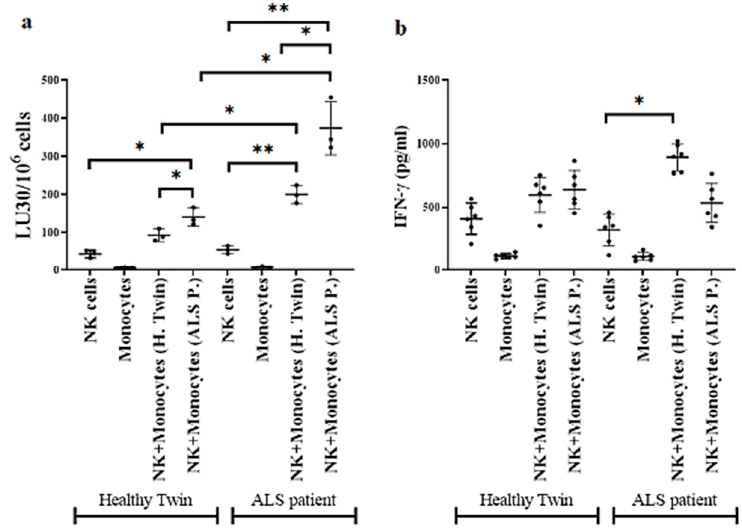
Figure 3. Autologous and allogeneic monocytes from ALS patients and those of healthy individuals increase NK cell-mediated cytotoxicity and secretion of IFN-g. NK cells and monocytes from ALS patients and healthy individuals were isolated from PBMCs as described in Material and Methods section. NK cells were treated with a combination of IL-2 (1000 U/mL) and anti-CD16 mAbs (3 µg/mL). A crisscross NK cells and monocyte co-cultures were performed with 3 sets of NK cells with allogeneic and autologous monocytes. NK cell- mediated cytotoxicity were measured 18 h after co-culture using standard 4 h 51 Cr release assay against OSCSCs. The lytic units (LU) 30/10 6 cells were determined using inverse number of NK cells needed to lyse 30% of target cells OSCSCs ×100 ( n = 3) ( a ). NK and monocyte co-cultures were performed as described in ( a ). After 18 h of co-culture, supernatants were harvested and used in ELISA to measure IFN- γ secretion ( n = 6) ( b ). ** ( p -value 0.001–0.01), * ( p -value 0.01–0.05).